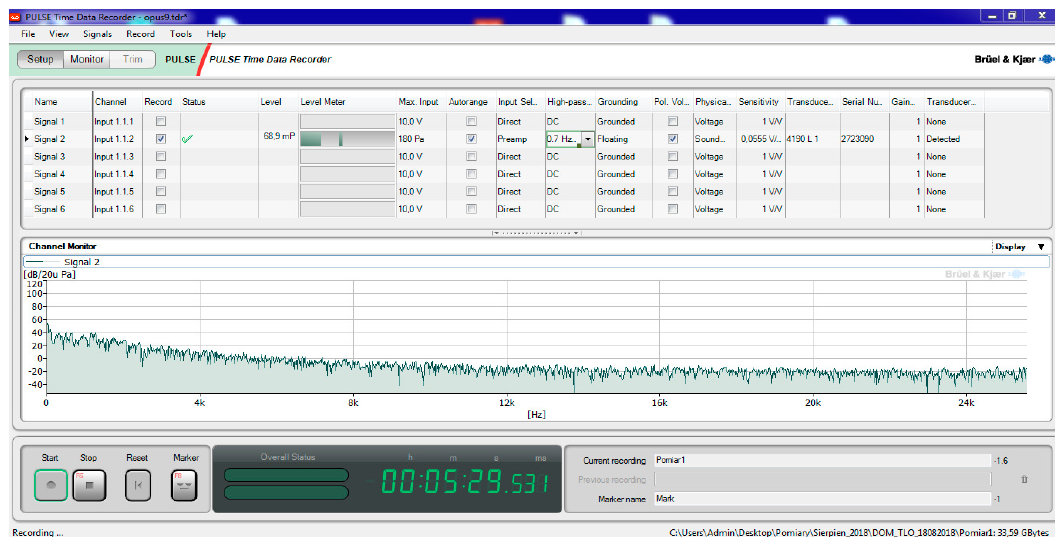
Figure 3. PULSE LabShop application screenshot.